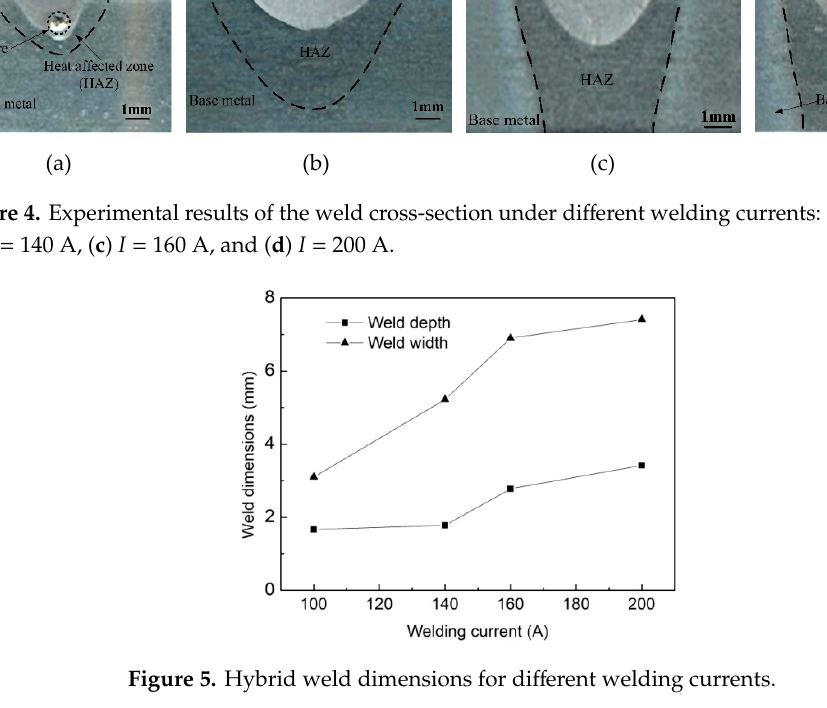
Figure 6. Pore distributions at the longitudinal section of the weld bead under different welding currents: ( a ) I = 100 A, ( b ) I = 140 A, ( c ) I = 160 A, and ( d ) I = 200 A. To further investigate the influence of arc power on keyhole-induced porosity, the pore size and distribution in the hybrid weld zone were measured using X-ray radiography. Figure 7 shows the X-ray NDT photos of weld beads for different welding currents. It is observed that the pores tend to gather at the region close to the weld center. Meanwhile, corresponding to the observed results shown in Figure 6, the number of pores gradually decreases when increasing the current from 100 A to 200 A. Figure 7. X-ray NDT photos of welds for different welding currents: ( a ) I = 100 A, ( b ) I = 140 A, ( c ) I = 160 A, and ( d ) I = 200 A. Figure 8 provides the variation trend of the weld percent porosity under different welding currents. It is revealed that the percent porosity in hybrid welding of the aluminum alloy has a sharp decrease from 18.4% to almost 6.6% as the welding current increases from 100 A to 200 A. One